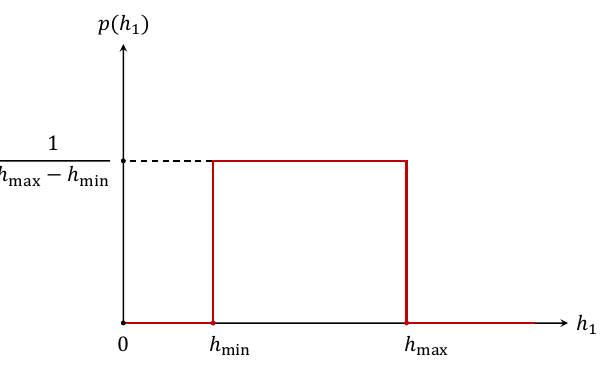
Figure 4. An exemplary uniform probability density function for sea-level